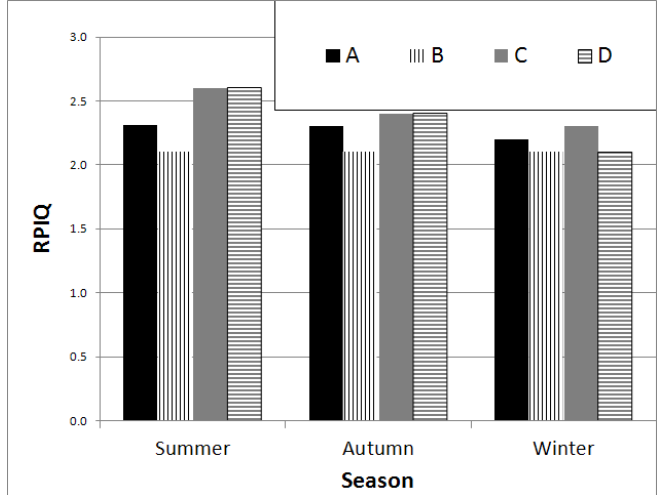
Figure 7. Bar plot of mean ratio of performance to inter-quartile range (RPIQ) values for clay estimation using simulated PRISMA data by means of different models according to soil moisture content both with clay indices (A) and PLSR (C), and by the use of synthetically dried spectra both with clay indices (B) and PLSR (D).